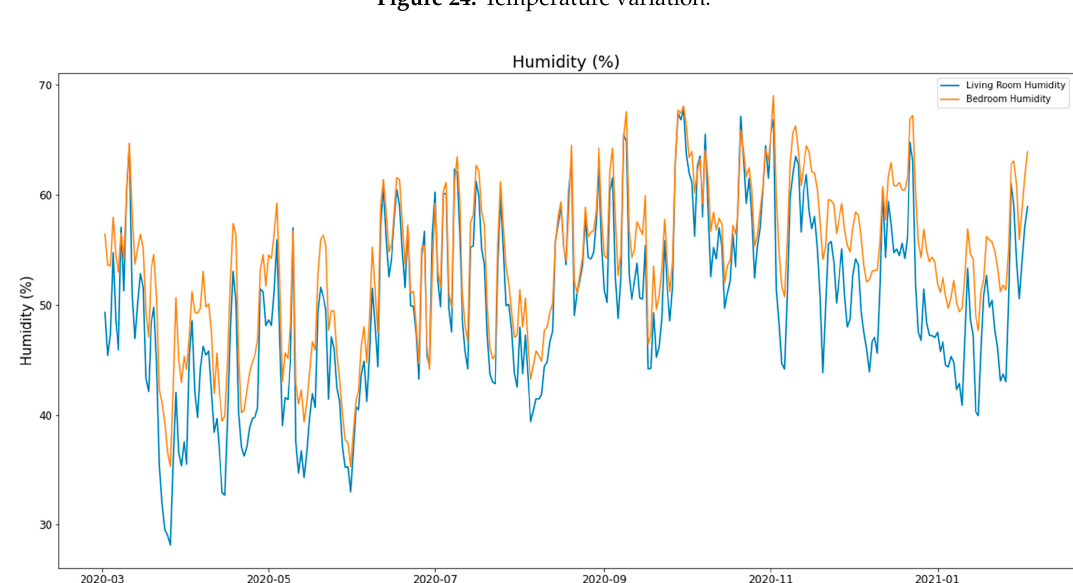
Figure 26. Energy consumption.